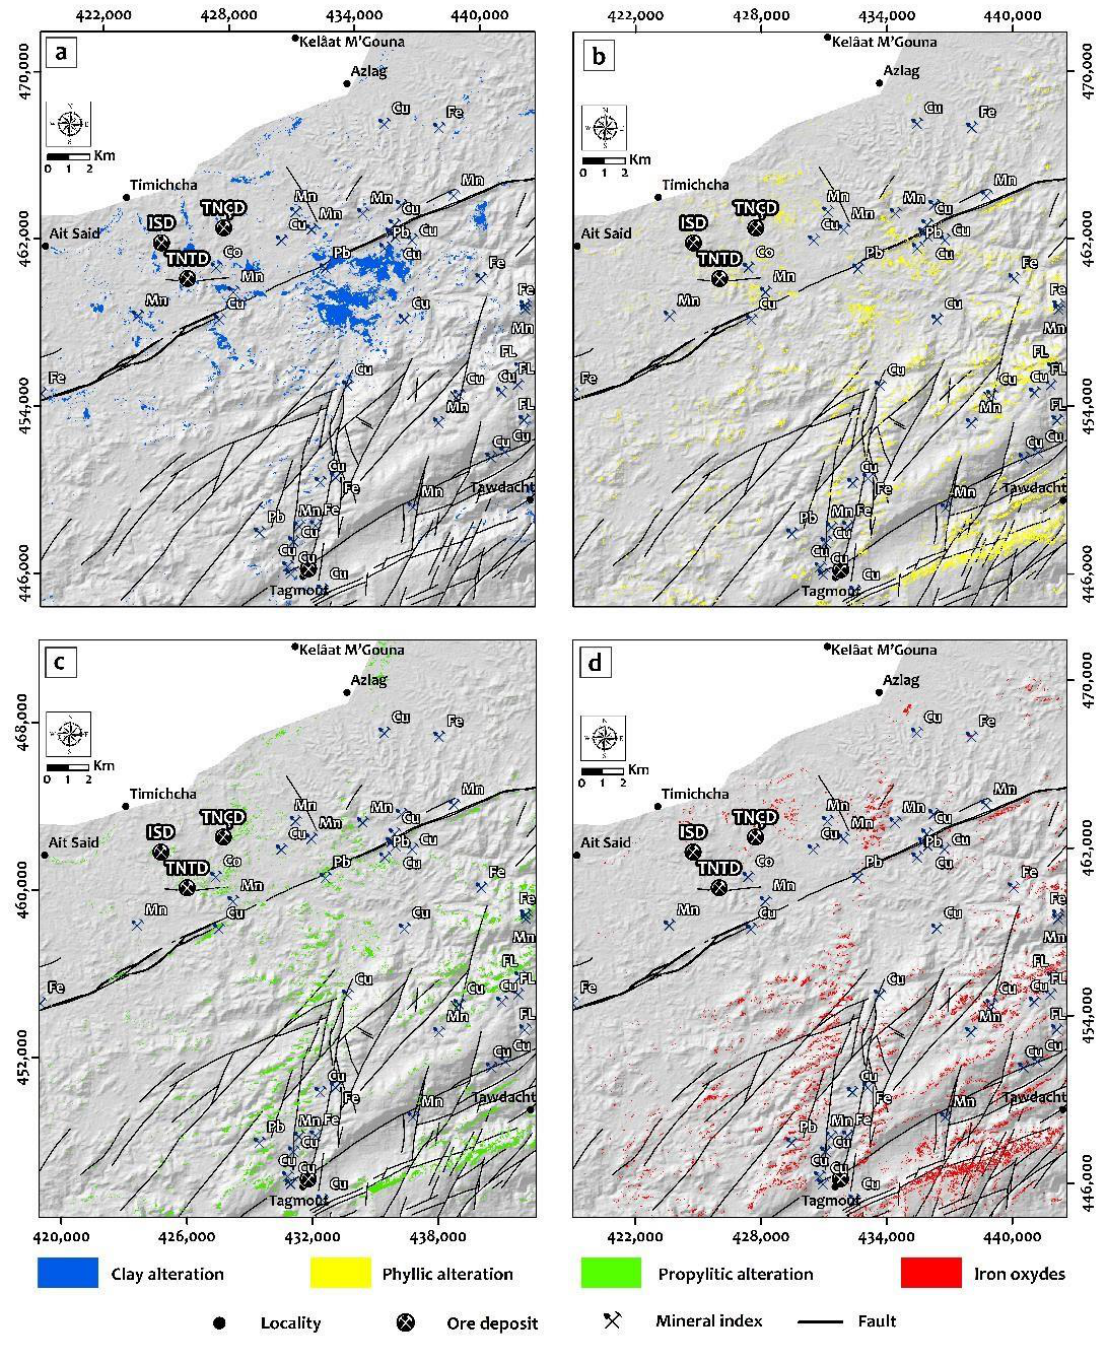
Figure 5. Band ratio maps derived from the ASTER image showing the distribution of anomalous clay minerals (a), phyllic minerals (b), propylitic minerals (c), and iron oxides (d).